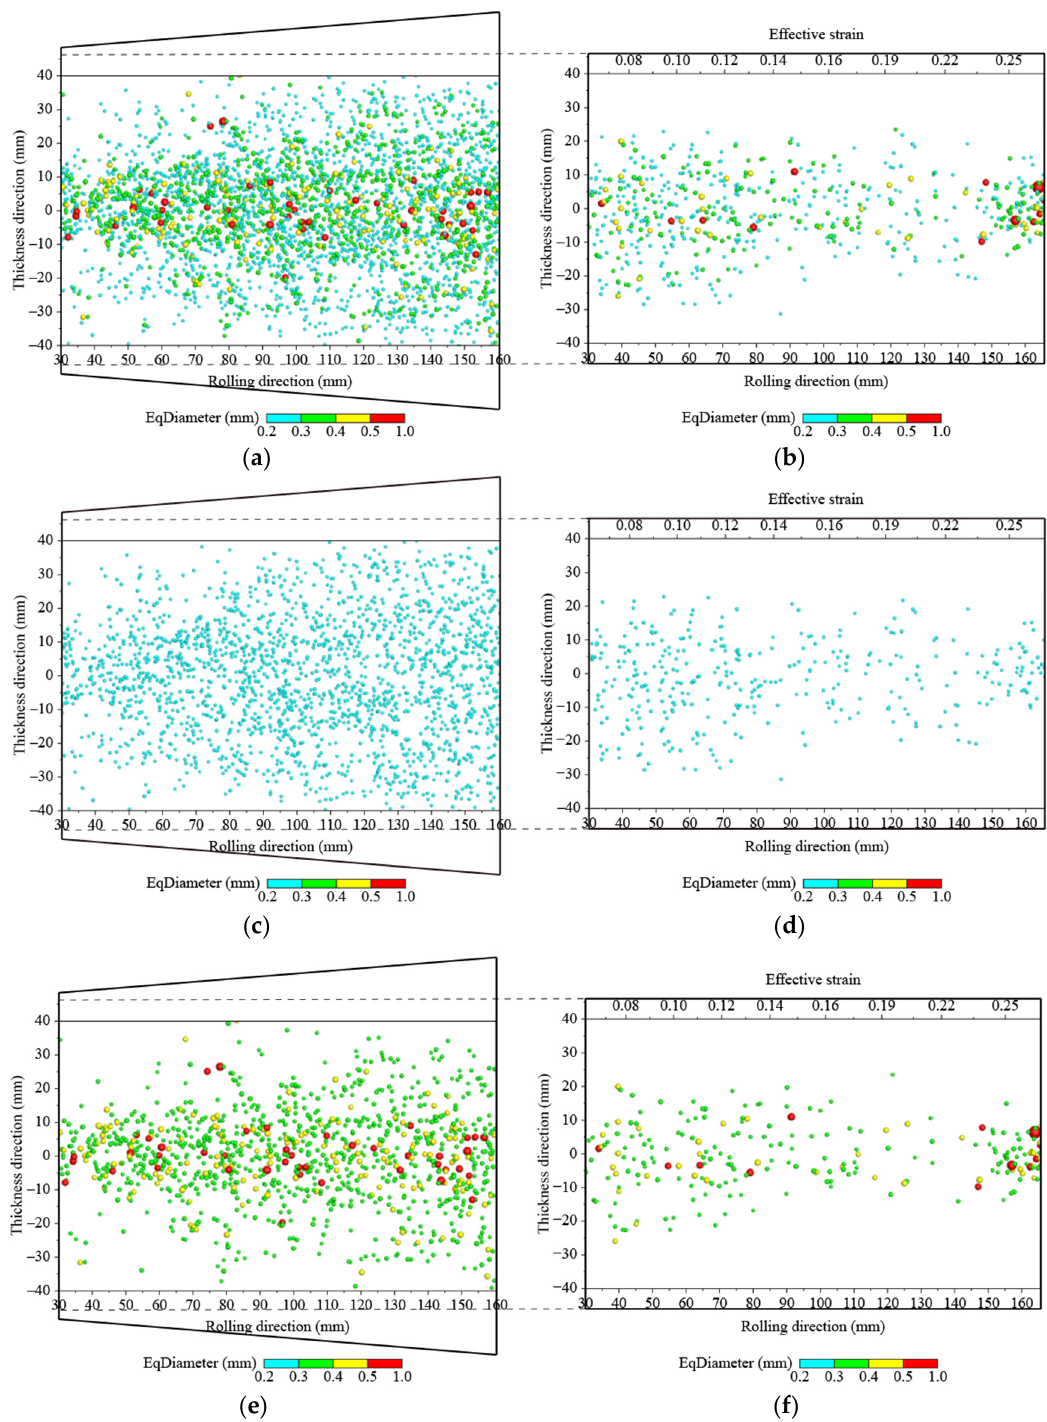
Figure 10. Defects distribution diagrams of porosities in the specimens: ( a ) all porosities in the specimen without reduction; ( b ) all porosities in the specimen with reduction; ( c ) small porosities in the specimen without reduction; ( d ) small porosities in the specimen with reduction; ( e ) large porosities in the specimen without reduction; ( f ) large porosities in the specimen with reduction.